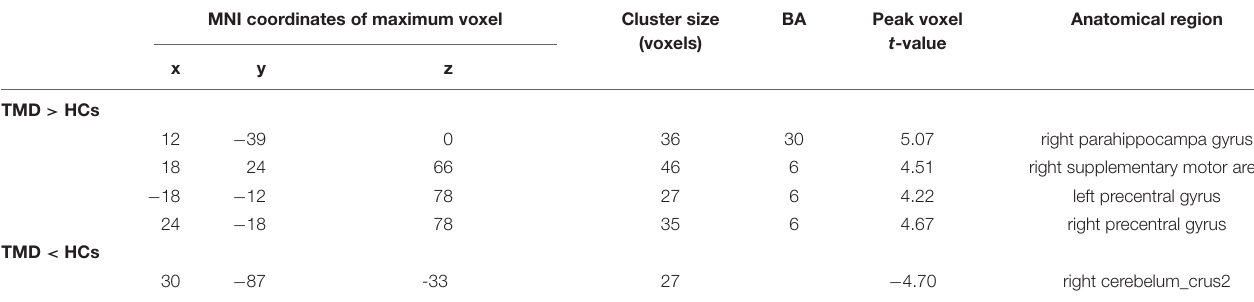
TABLE 2 | Brain regions showing significant differences in amplitude of low-frequency fluctuation (ALFF) between groups. MNI coordinates of maximum voxel Cluster size